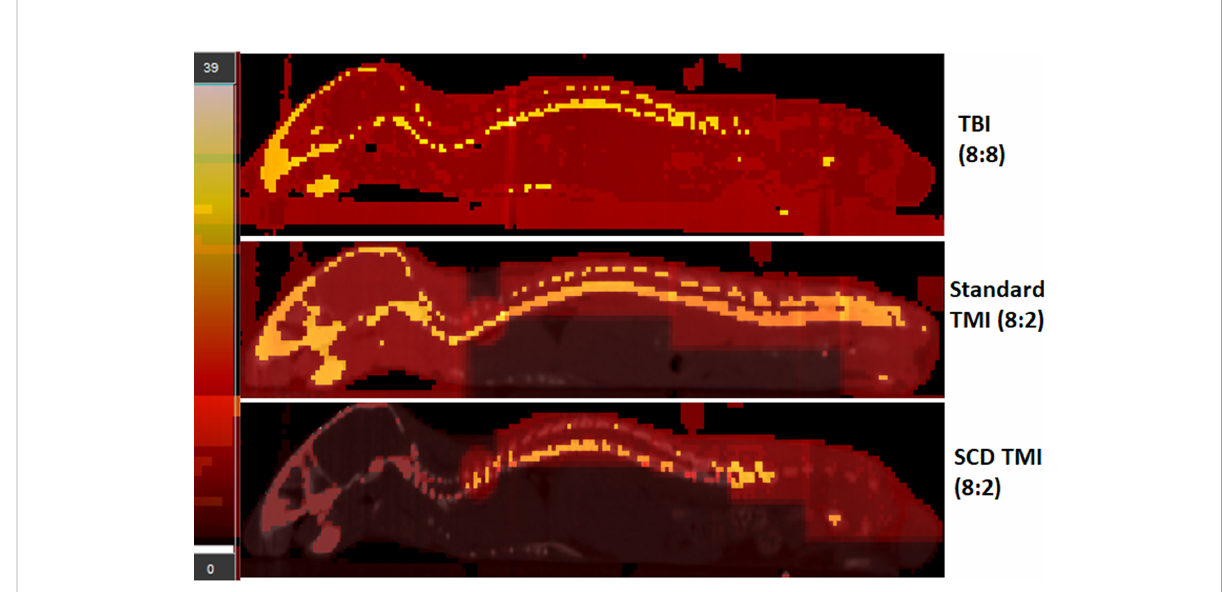
FIGURE 1 The modi fi ed TMI plan for SCD mouse. The TBI (8:8), standard TMI (8:2), and modi fi ed TMI (8:2) treatment plan for SCD are shown. The standard TMI (8:2) plan was modi fi ed by slightly adjusting the beam placements on the spine over the lung and kidney region. In addition, the dose to the skull was maintained at 2 Gy while the rest of the skeletal system received a prescription dose of 8 Gy. The dose painting clearly shows the difference in dose distribution in the new SCD TMI mice plan. The skull, face, and vital organs like liver, lung, and GI receive only ~2 Gy while the rest of the skeletal system is delivered with the prescribed dose. In addition, the TBI (8:8) mice dose painting clearly shows full prescription dose (~8Gy) to all the